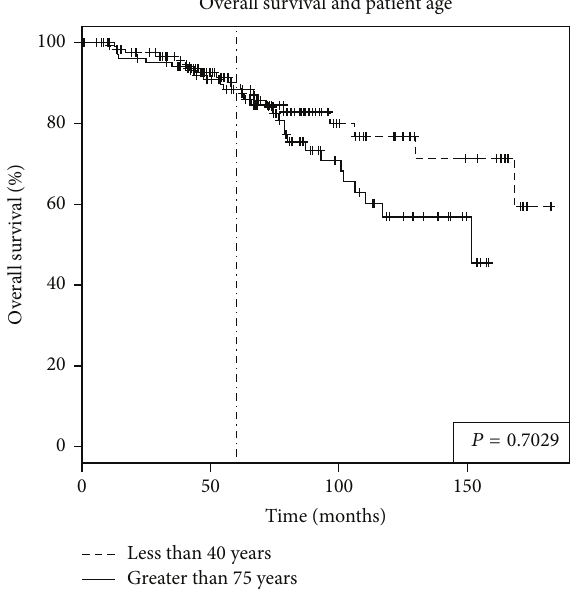
Figure 3: Overall survival (OS) in breast cancer patients based on patient age. Women younger than age of 40 and women older than age of 75 did not have significantly different OS. The 5-year rate of OS was 90% versus 88.3% ( 𝑃 = 0.7029